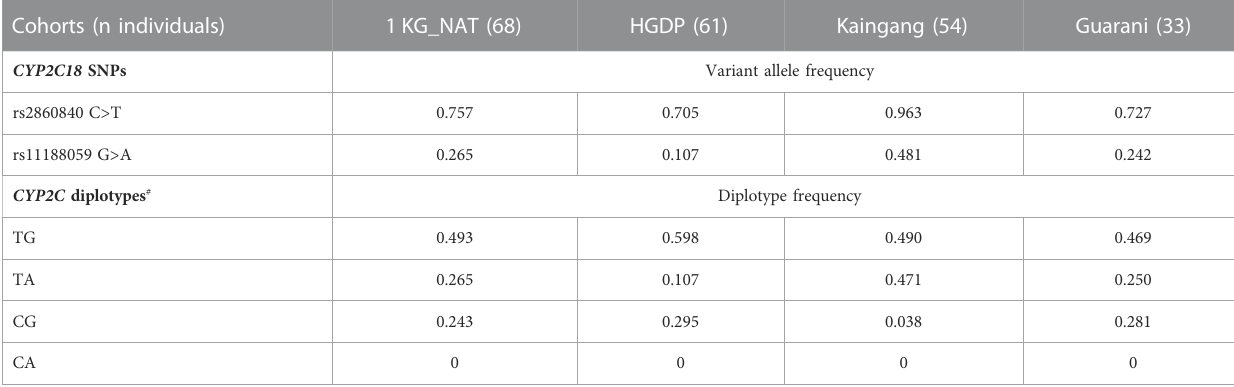
TABLE 1 Distribution of CYP2C18 alleles and CYP2C diplotypes in Native Americans. Cohorts (n individuals) 1 KG_NAT